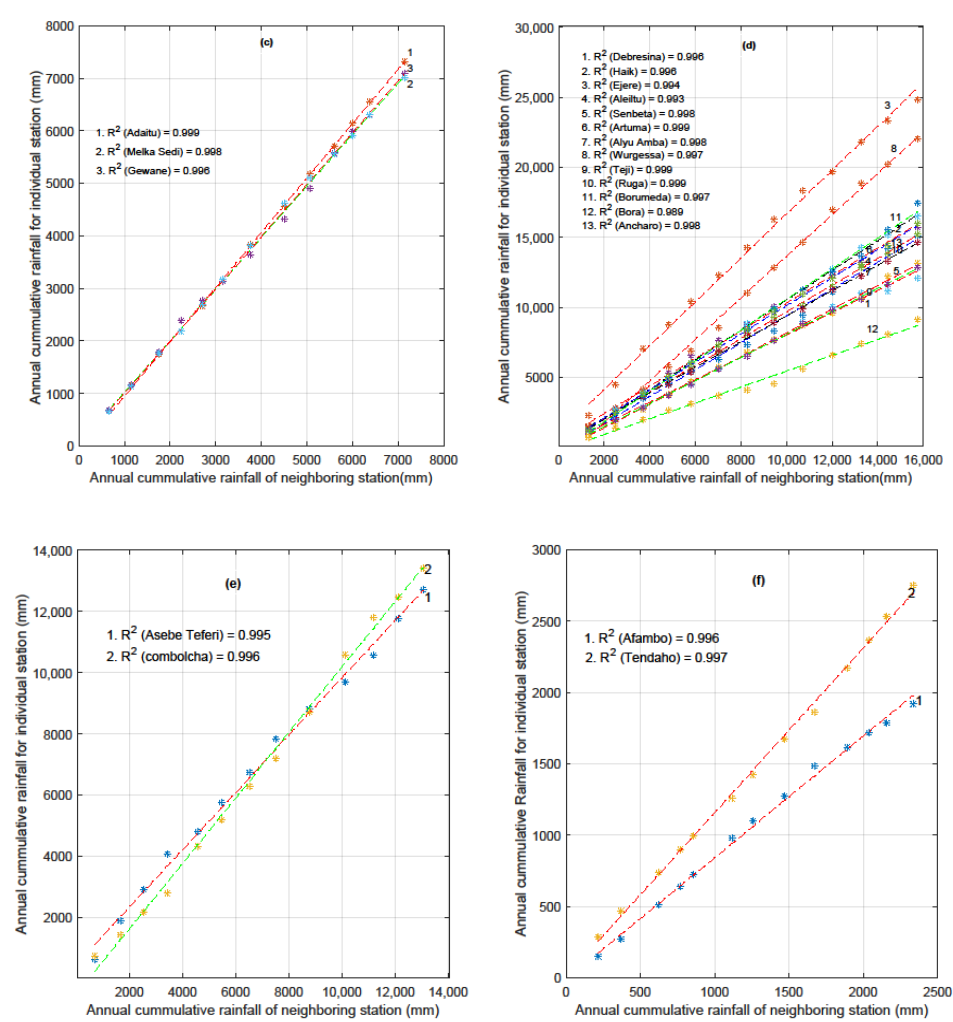
Figure 2. Consistency test for 41 stations in the ARB: ( a ) upland sub-basin; ( b ) upper valley sub-basin; ( c ) middle valley sub-basin; ( d ) western highland catchments; ( e ) eastern catchments; ( f ) lower Awash sub-basin.